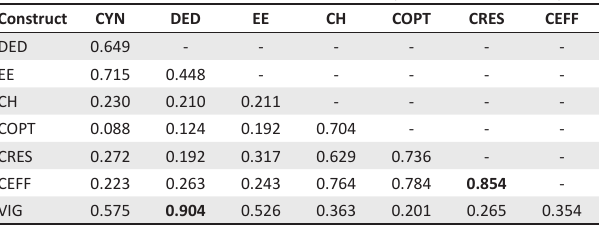
TABLE 2: Heterotrait-monotrait ratio of correlations (first-order constructs).